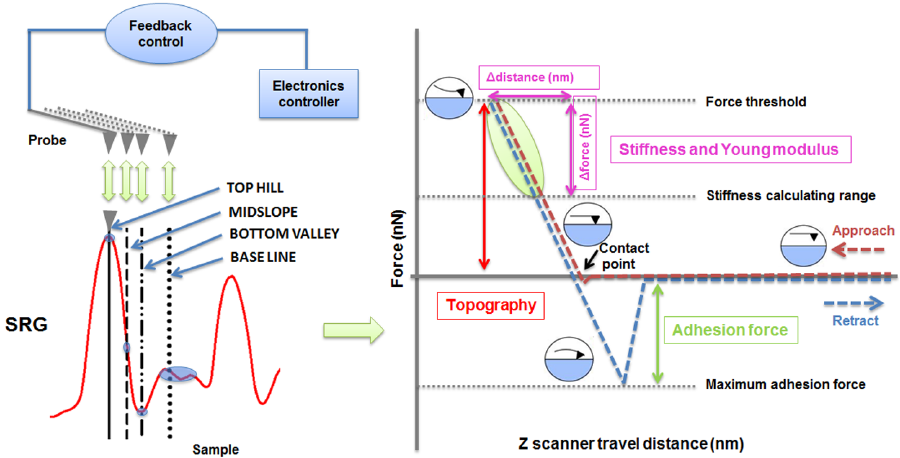
Figure 5. Working mechanism of PinPoint Nanomechanical mode: the tip of the cantilever is moved at each of 256 × 256 points along a sample’s surface, and the feedback system controls the approach and retraction of a probe, allowing the acquirer of both surface topography and force–distance curves, and further to extract the mechanical property